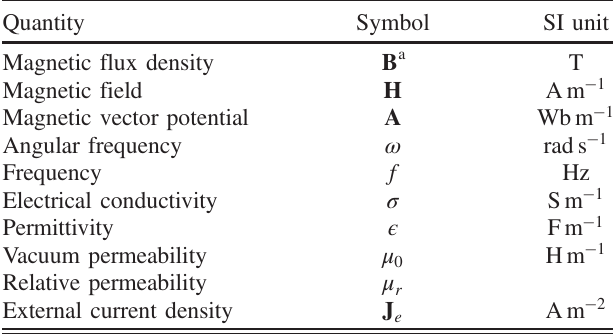
TABLE I. Characteristic angles [deg] and dimensions [mm] of the beam screens analyzed in this paper, for LHC see Fig. 16. Symbol Q1